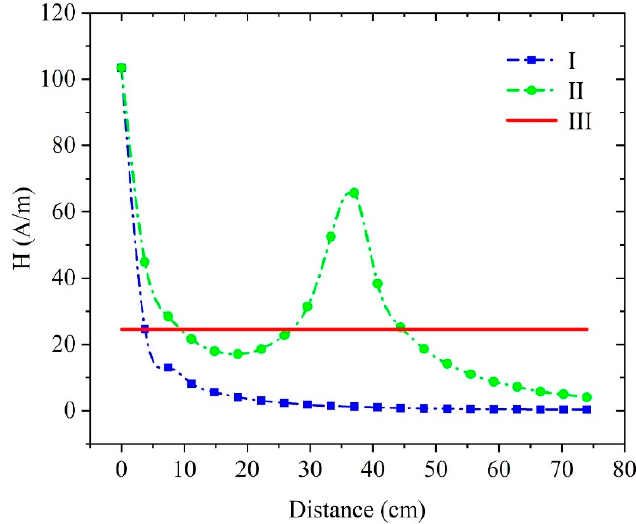
Figure 11. H-field strength along lines I, II and reference level III.